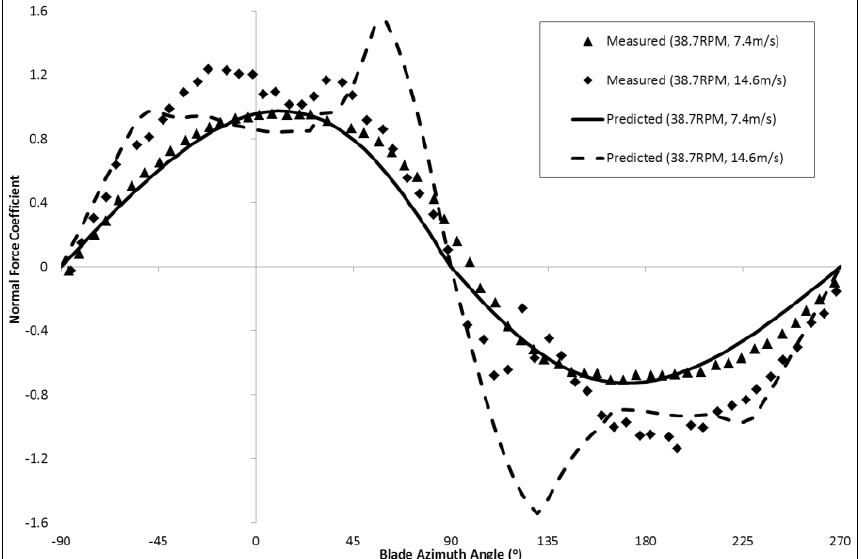
Figure 7. Sandia 17 m Φ-rotor variation of equatorial normal force coefficient with blade position (38.7